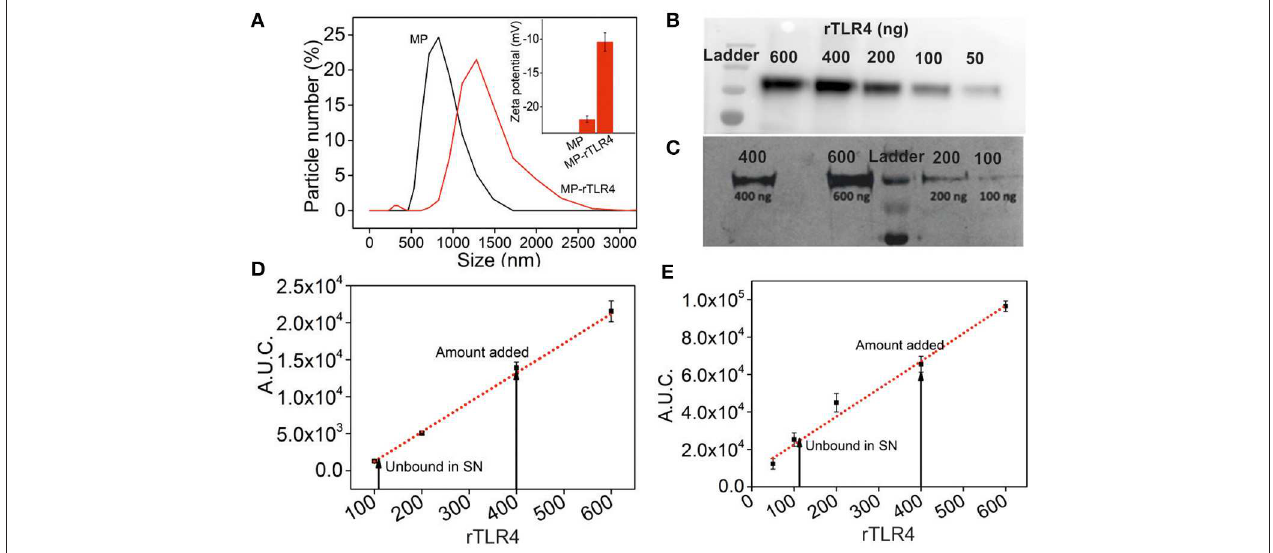
FIGURE 2 | Characterization of rTLR4 binding to MPs. (A) A dynamic light scattering plot showing the hydrodynamic particle size distribution and the expected size increase of magnetic nanoparticles before and after rTLR4 conjugation (rTLR4:MP::10:431 g/g). The inset shows the corresponding change in surface charge potential. Typical gel patterns obtained for the supernatant using (B) western blot and (C) silver staining after magnetic removal and their respective rTLR4 calibration charts, (D,E) obtained after quantifying the color intensity of each block and integrating the area under curve (A.U.C.) ( n =